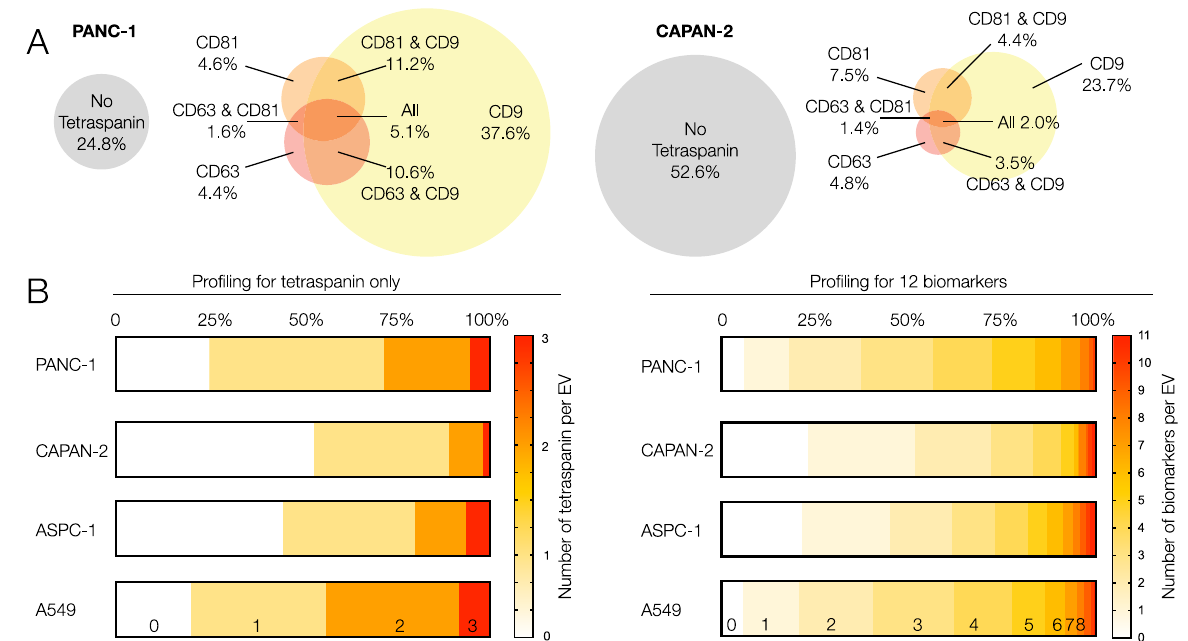
B Analysisof tetraspanin(left) or 12biomarkerconcurrence (right;see TableS1for markers) across individual EV obtained from four cell lines. Only 2 – 10% of all EV show all three tetraspanins. Roughly 50% of all vesicles show <3 of the 12 other biomarkers combined in a given vesicle. Only a small percentage of vesicles shows >5 of the